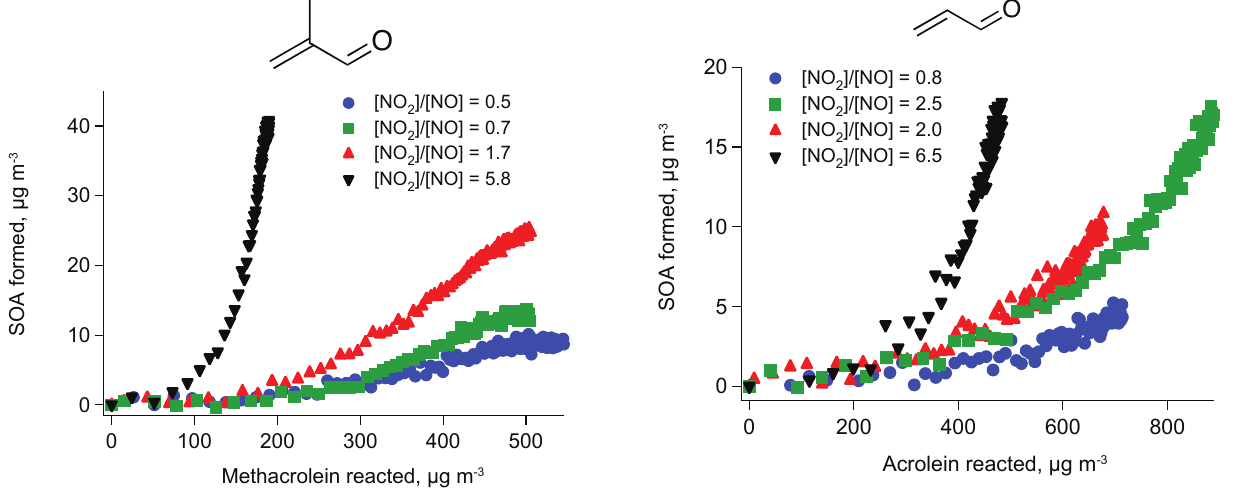
Fig. 3. Time-dependent SOA growth curves for methacrolein photooxidation. NO 2 /NO ratios are computed from photochem- ical modeling (see Appendix). In the high-NO experiments (NO 2 /NO < 2) HONO was used as the OH precursor, and the NO 2 /NO ratio was varied by adding different amounts of NO or NO 2 . In the high-NO 2 experiment (black triangles), CH 3 ONO was used as the OH precursor.